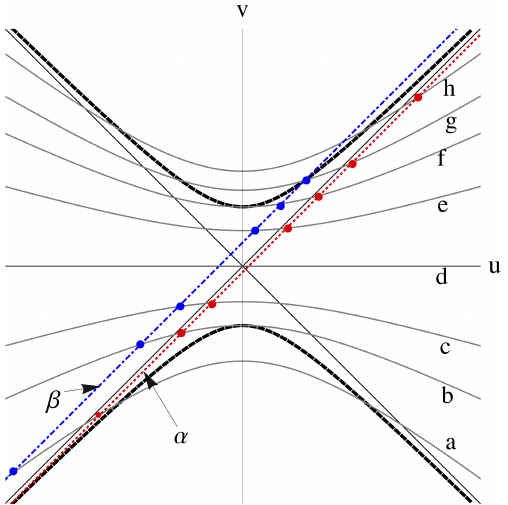
Figure 3. The red dotted line is the geodesic of photon α from Region IV, while the blue one is that of photon β from Region III. After passing through the anti horizon v = − u , photon α goes to Region I and never across the event horizon v = u . The geodesic of photon β must terminate at the singularity r = 0 in a finite time in Region